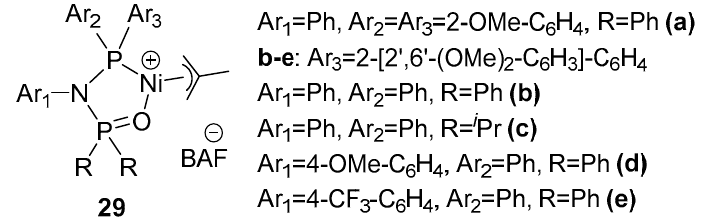
Figure 26. The diphosphazane monoxide (PNPO) nickel catalysts 29a – e